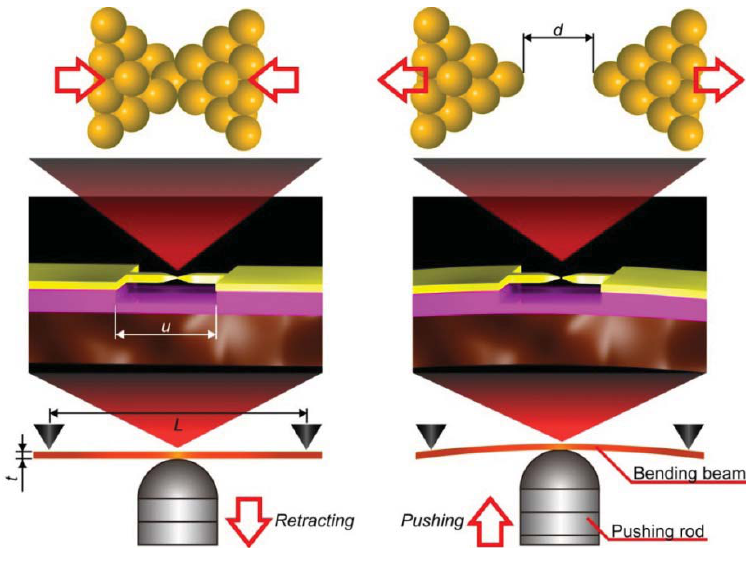
Figure 3. Principle of operation of micro-fabricated MCBJs. The MCBJ set up (bottom) is comprised of a free-standing metal junction formed on a polyimide-coated phosphor bronze substrate using electron beam lithography and metal deposition processes (middle). The narrowest constriction at the center is usually sub-micrometer size. The phosphor bronze substrate is deflected by the pushing rod in a three-point bending configuration, which induces the tensile force on the free-standing junction to break it. After breaking, an electrode gap of size d is formed (top). Thereafter, the electrode gap distance can be finely tuned by the vertical displacement of the pushing rod D by d = rD , where r is the attenuation factor roughly determined by the device configuration as r = 3 ut / L . Usually, r is estimated by measuring the exponential decay of the current flowing across the electrode gap with increasing D in a